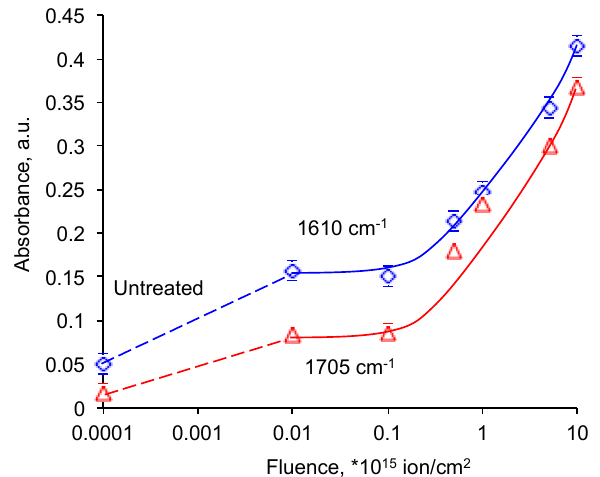
Figure 7. Normalized absorbance of ν (C=C) = 1610 cm − 1 line and ν (C=C) = 1610 cm − 1 line in FTIR ATR spectra of EPDM rubber with fluence of PIII.